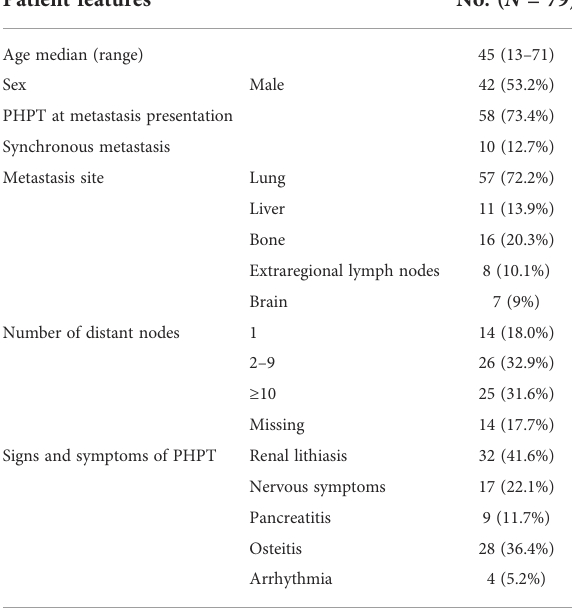
TABLE 1 Patient characteristics.